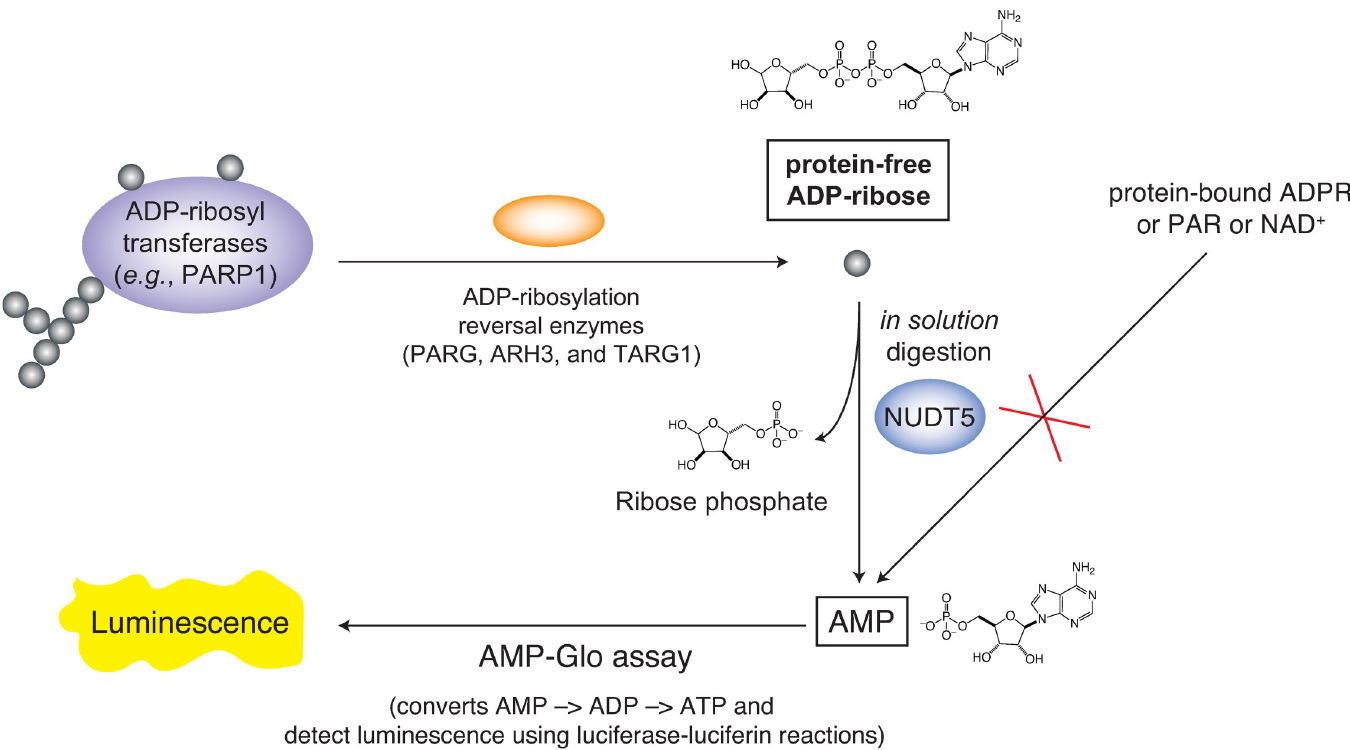
Fig 1. A scheme for the NUDT5-coupled AMP-Glo (NCAG) assay. NUDT5 has a unique substrate selectivity and can selectively cleave the protein-free mono-ADP- ribose into AMP and ribose phosphate, but not protein-bound ADP-ribosylations or protein-free poly(ADP-ribose) or NAD + . The cleaved AMP is subsequently detected by the AMP-Glo